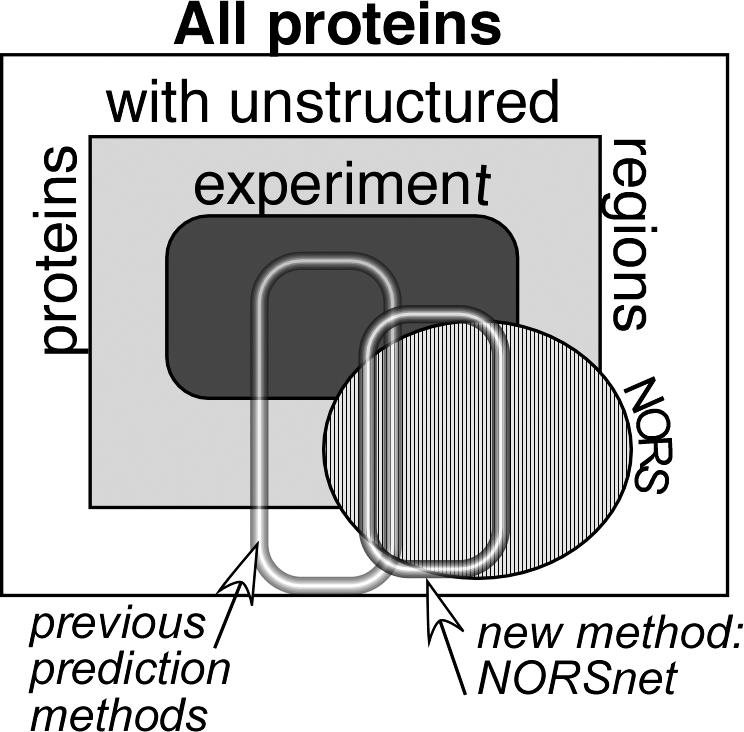
Putative “Map” of Unstructured RegionsProteins with unstructured regions are likely to occupy large portions of sequence space [7,24,27,42] as sketched by the light-gray inner rectangle. The space of all proteins with unstructured regions is likely to be considerably larger than what today's experimental techniques capture. The rounded darker gray rectangle labeled experiment sketches proteins for which some experimental method annotated natively unstructured regions. While most NORS regions (predicted long loops, striped gray ellipse) are likely to be natively unstructured, many unstructured regions are not NORS; i.e., they contain helices and strands even in their native form. Previous methods for the prediction of unstructured regions (left lens) are optimized to somehow reflect today's experiments. In contrast, the method introduced here (NORSnet, right lens) is developed based on predictions. This is an advantage because it avoids the bias of today's experimental techniques in a field that is just beginning to grasp its own dimensions, and it is a disadvantage because performance on today's datasets appears somehow limited.